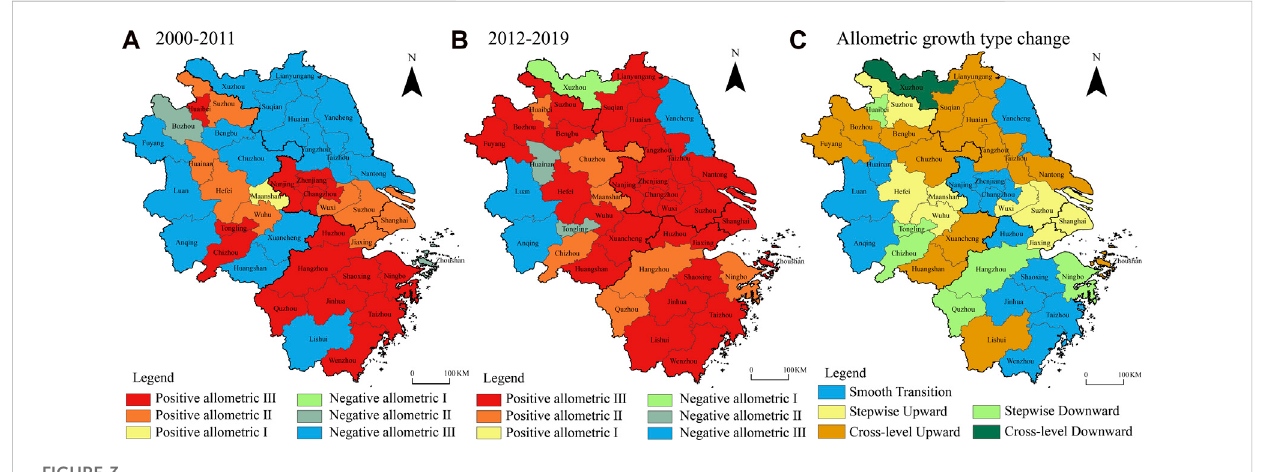
FIGURE 3 Distribution of population-land allometric growth types in the YRD from 2000 to